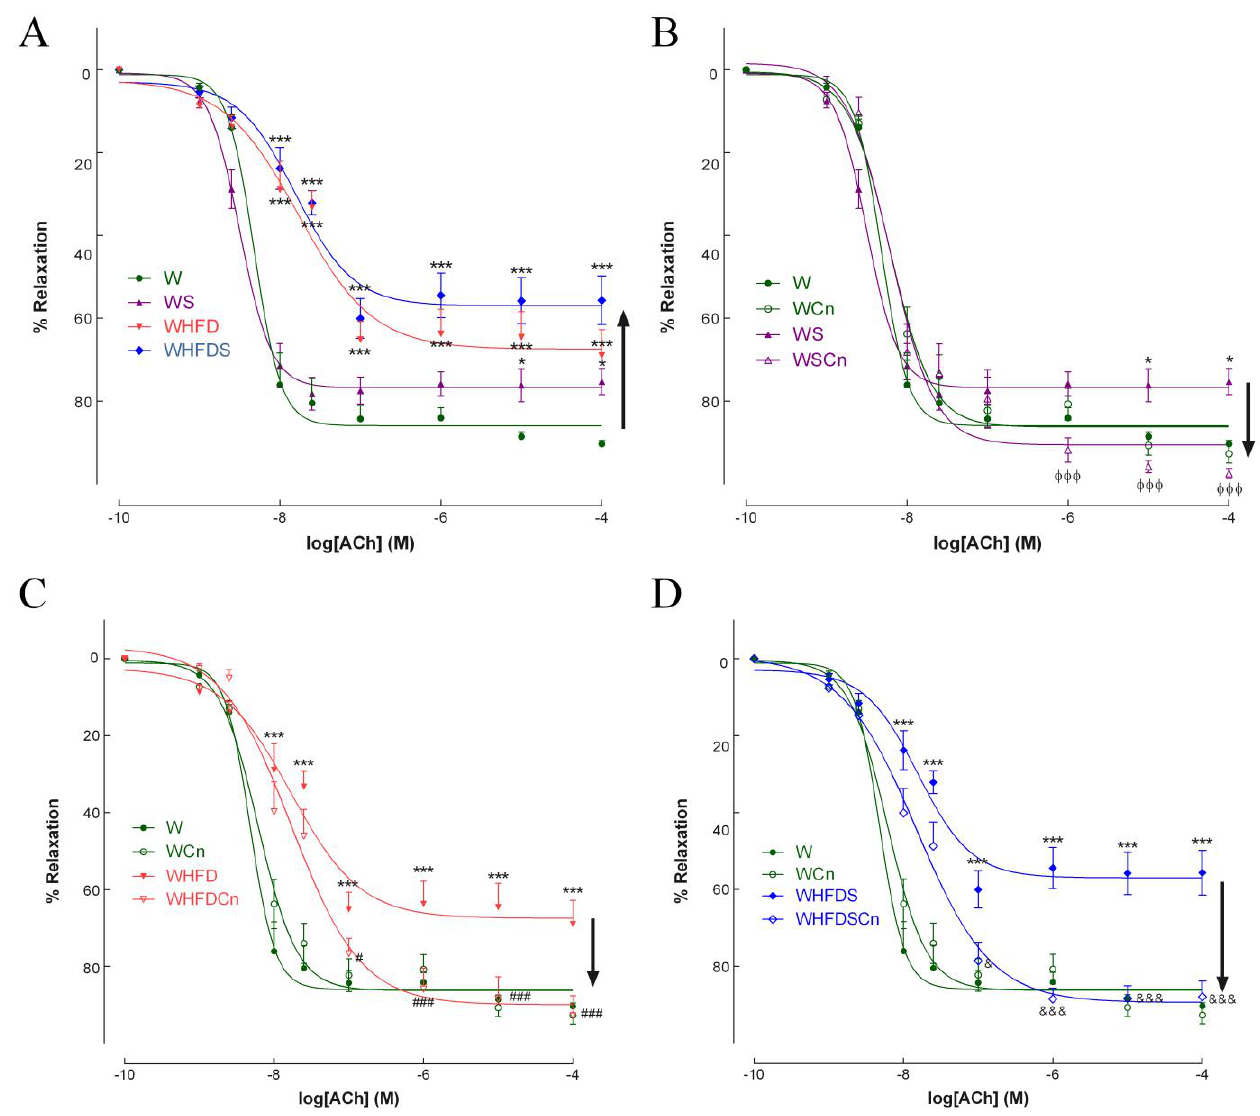
Figure 3. Effects of cinnamaldehyde (Cn) treatment on vasodilatory responses to acetylcholine in mesenteric arteries of 8-months-old Wistar (W, A ) rats fed with sucrose (WS, B ), high-fat diet (WHFD, C ) or both (WHFDS, D ), compared to normal W rats. Data are expressed as mean ± SE (n = 12 animals per group). * p < 0.05, *** p < 0.001 vs. W rats; φφφ p < 0.001 vs. WS rats; # p < 0.05, ### p < 0.001 vs. WHFD rats; & p < 0.05, &&& p < 0.001 vs. WHFDS